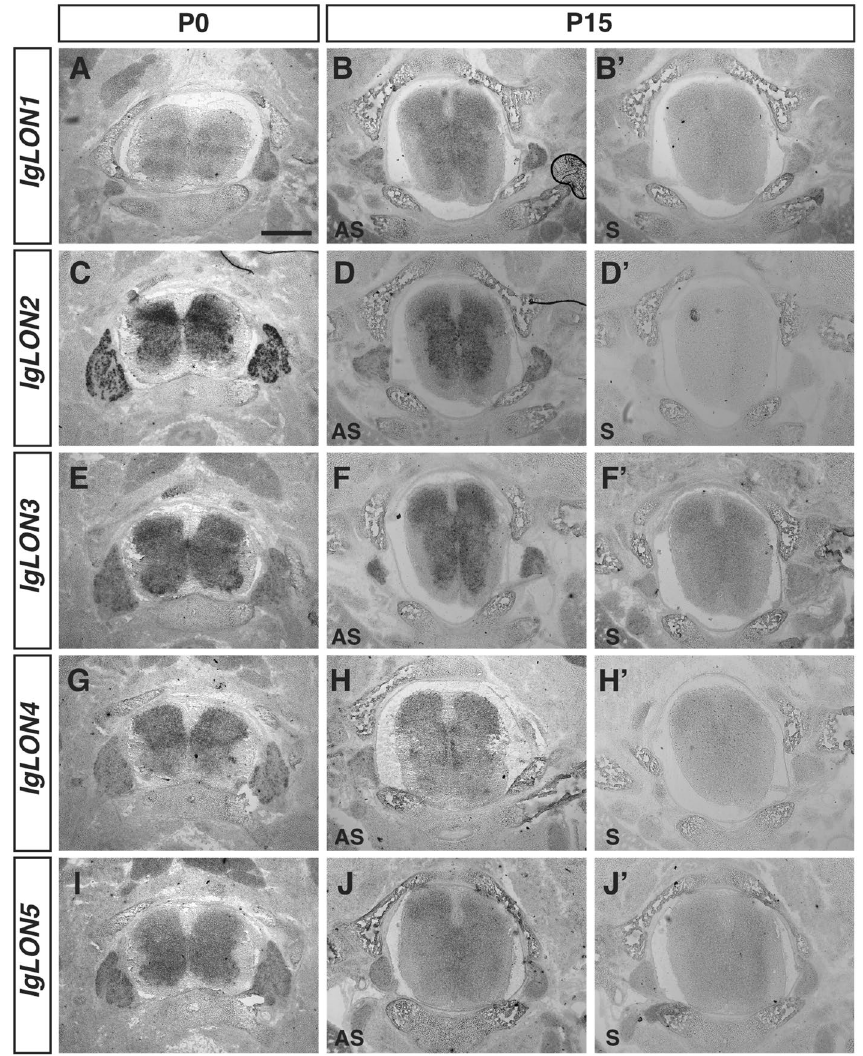
Figure 8. IgLONs mRNA expression during spinal cord development. In situ hybridization of coronal sections of the spinal cord from P0 and P15 mice with antisense ( A – J ) or sense ( B ′ – J ′ ) cRNA probes for IgLON transcripts. IgLON1 , IgLON2 , IgLON3 , IgLON4 , and IgLON5 mRNAs are detected at various levels in the gray matter of the spinal cord at P0 and P15 ( A – J ). At P0, higher levels of expression of IgLON2 and IgLON4 are observed in the dorsal region of the spinal cord ( C , G ) while higher levels of IgLON3 and IgLON5 are detected in the ventral part of the spinal cord at P0 (I). All IgLON family members are expressed in sensory neurons within the dorsal root ganglia at P0 ( A , C , E , G , I ) while only IgLON1 , IgLON2 , and IgLON3 mRNAs could be detected in these structures at P15 ( B , D , F ). Scale bar = 1